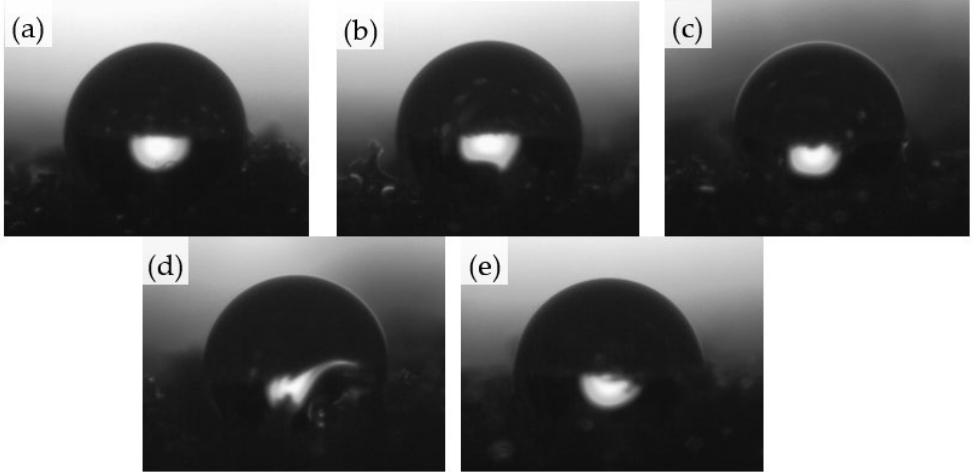
Figure 8. Selected properties of PU foams: contact angle and water uptake results.